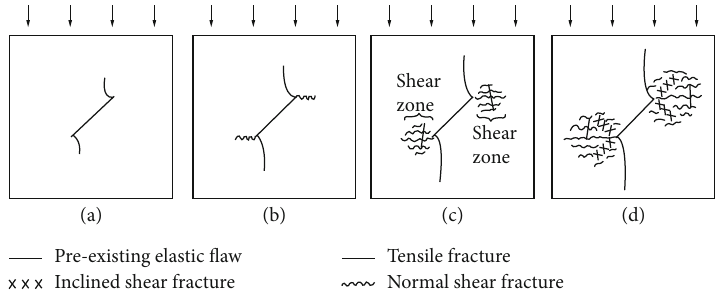
Figure 18: The evolution of fracture from a single open fl aw observed by Lajtai [30].